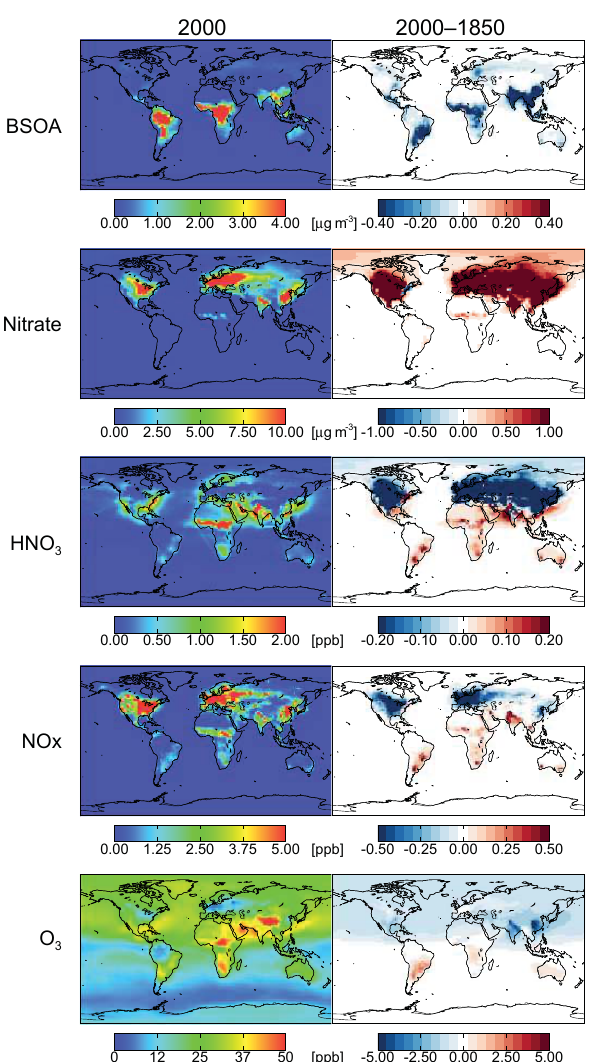
Figure 8. Boreal wintertime (December–February) mean simulated surface concentrations of biogenic SOA (BSOA), aerosol nitrate, nitric acid (HNO 3 ) , nitrogen oxides (NO x ), and ozone. Concentra- tions for present day (2000) shown on the left; the change due to historical land use change is shown on the right. All simulations per- formed with present-day (2000) anthropogenic emissions; shown here are the differences between simulations 1 and 7 (see Tables 1 and